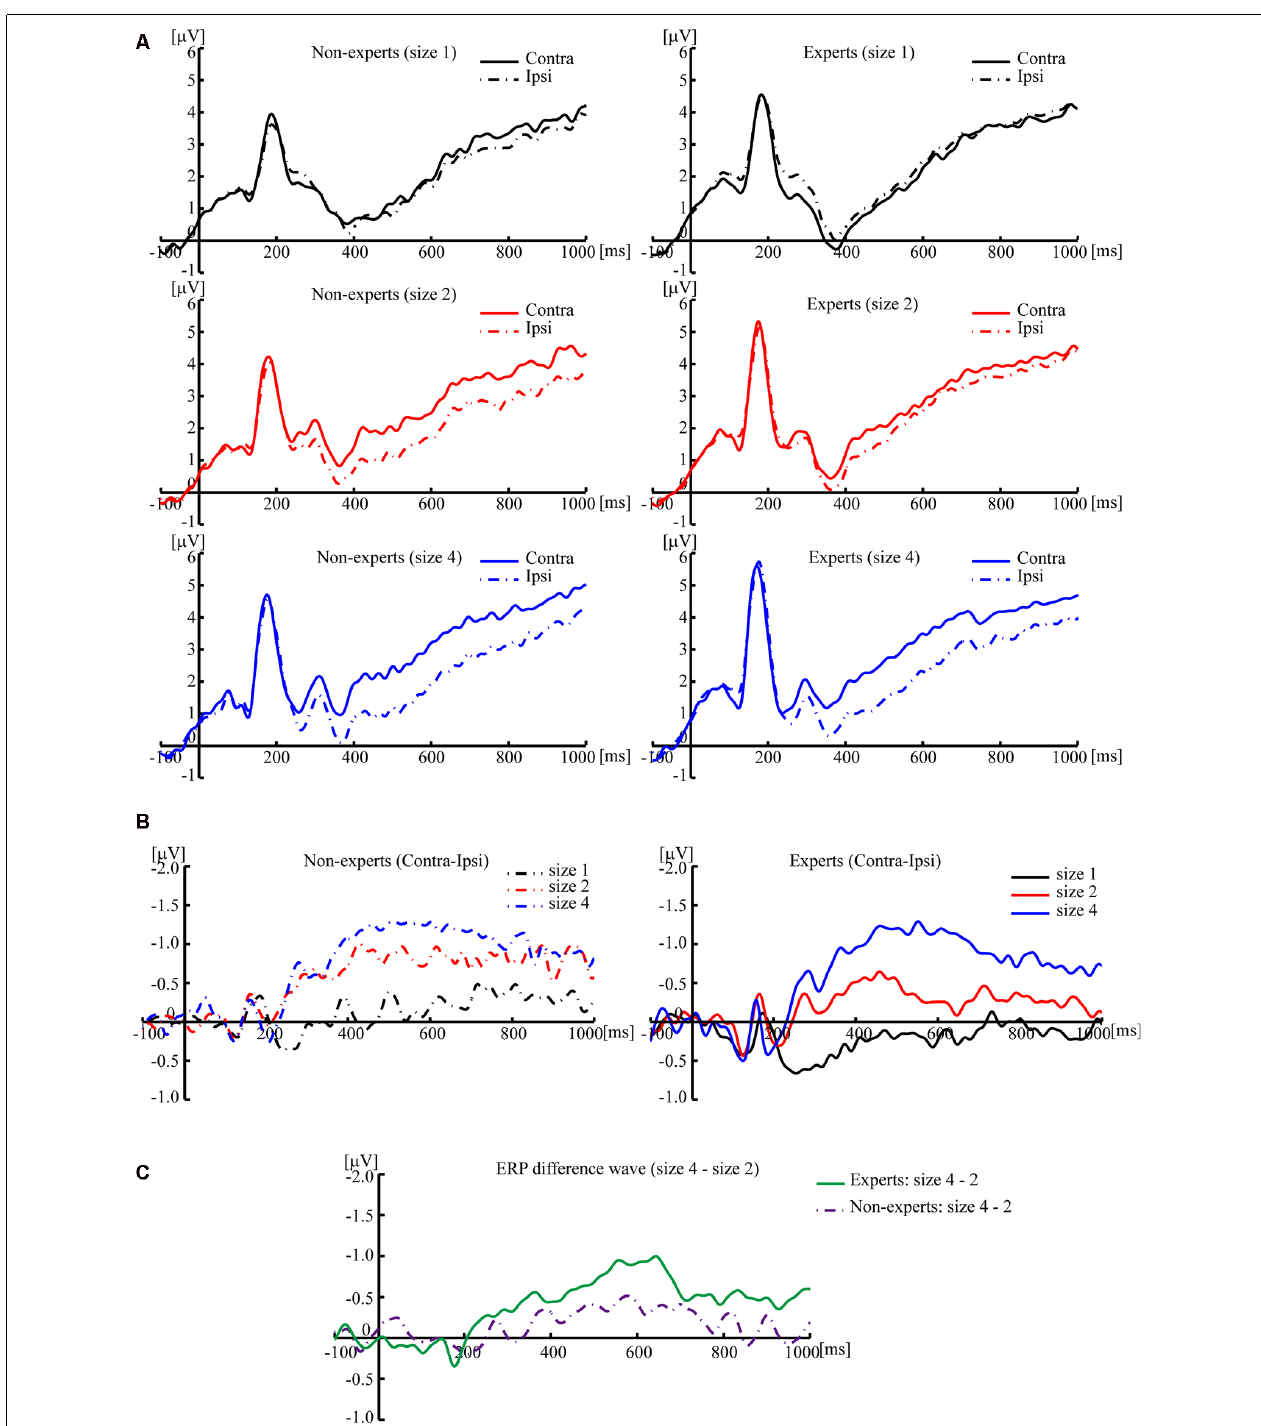
FIGURE 3 | Grand averaged event-related potentials (ERPs), elicited by memory array onset with the League of Legends (LOL) non-expert and expert groups. (A) Grand averaged ERPs of ipsilateral and contralateral brain regions, elicited by memory array onset with the LOL non-expert (left panels) and expert groups (right panels) at size 1, size 2, and size 4, respectively. (B) Grand averaged ERP difference waves that subtracted the ipsilateral activity from the contralateral activity, elicited by memory array onset with the LOL non-expert (left panels) and expert groups (right panels) at size 1, size 2, and size 4, respectively. (C) Grand averaged ERP difference waves with the amplitude of size 4 minus the amplitude of size 2, elicited by memory array onset with LOL non-experts and experts. The grand averaged wave was time-locked to the memory array onset and averaged across the posterior electrode pairs (CP1/CP2, CP5/CP6, P3/P4, P7/P8, and O1/O2). By convention, a negative voltage is plotted